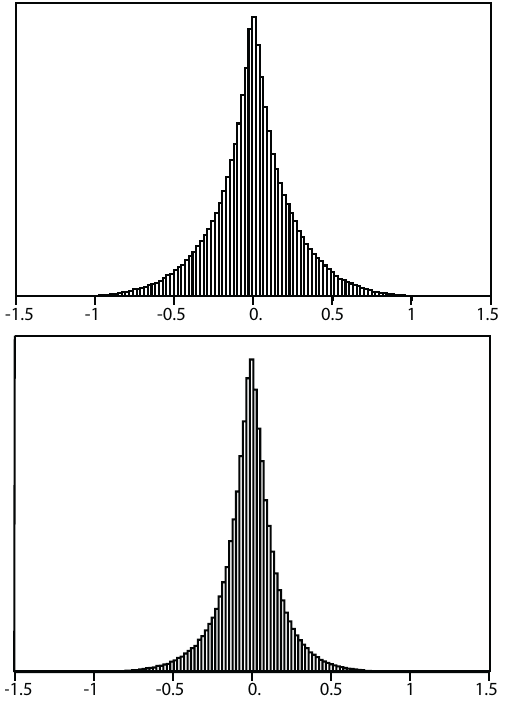
Fig. 3. Distribution of background error before translation (top) and after translation (bottom). Table 1. Descriptionof the eight assimilationexperiments: assump- tion for the B matrix, translation approach (no, T1 or T2), distance (in gridpoints) between the observations that are assimilated, score (r.m.s of analysis error) of the experiment.